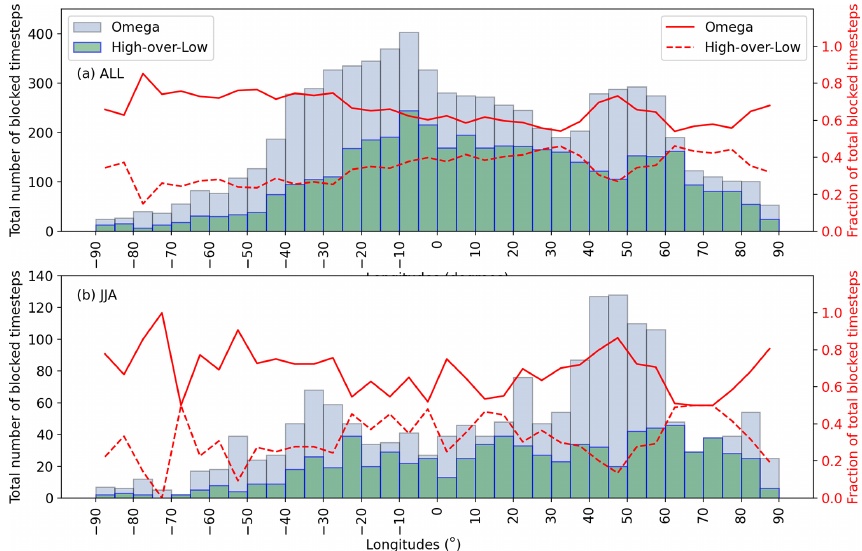
Figure 15. Number of total blocked time steps for omega and high-over-low blocks (columns) and percentage of omega (solid red line) and high-over-low (dashed red line) blocks with respect to total blocked time steps. Note that this analysis is based on (a) all blocked time steps and (b) blocked time steps in JJA in the period 1990–2019. No distinction has been made between onset and decay